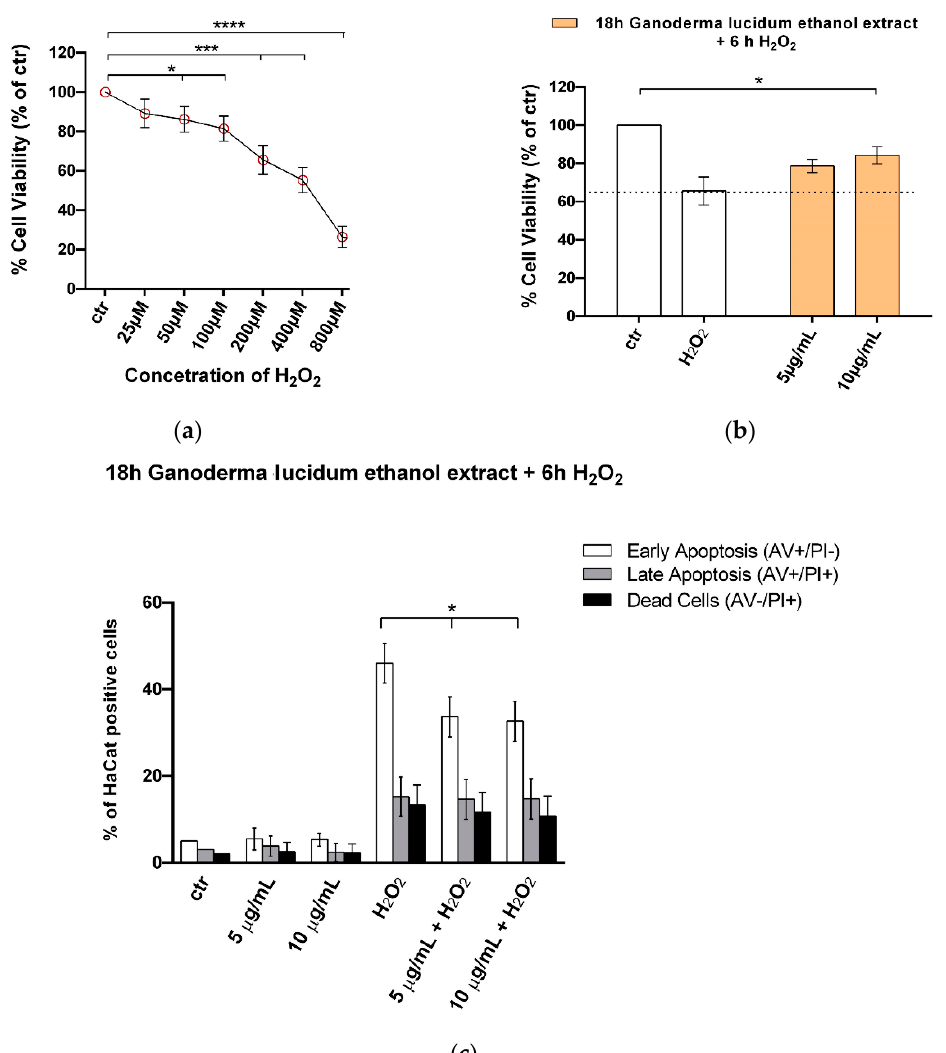
Figure 5. G. lucidum ethanol extract ameliorated cytotoxicity and apoptosis H 2 O 2 induced in HaCaT cells: ( a ) HaCaT cells were cultured for 6 h in the presence of the indicated concentrations of H 2 O 2 (25–800 µM) before MTT assay. The results are expressed as means ± SD of independent experiments performed in triplicate and are reported as percentage vs. the untreated control (ANOVA, * p < 0.05,*** p < 0.001 and **** p < 0.0001 vs. control). ( b ) HaCaT cells were cultured for 18 h in the presence of the indicated concentrations (0, 5 and 10 µg mL − 1 ) of the G. lucidum ethanol extract before treatment with H 2 O 2 for 6 h. The results are expressed as means ± SD of independent experiments performed in triplicate and are reported as percentage vs. the untreated control (ANOVA, * p < 0.05 vs. control). ( c ) Flow cytometric analysis of annexin V and propidium iodide (PI) double staining in the G. lucidum ethanol extract-treated HaCaT cells after 18 h and H 2 O 2 for 6 h: histograms indicate the total percentage of early (annexin V-positive cells/PI-negative cells) and late apoptotic events (annexin V/PI-double positive cells) as well as necrotic cells (annexin V-negative cells/PI-positive cells). The results are representative of four independent experiments performed in duplicate and are expressed as mean ± SD (ANOVA, * p < 0.05).